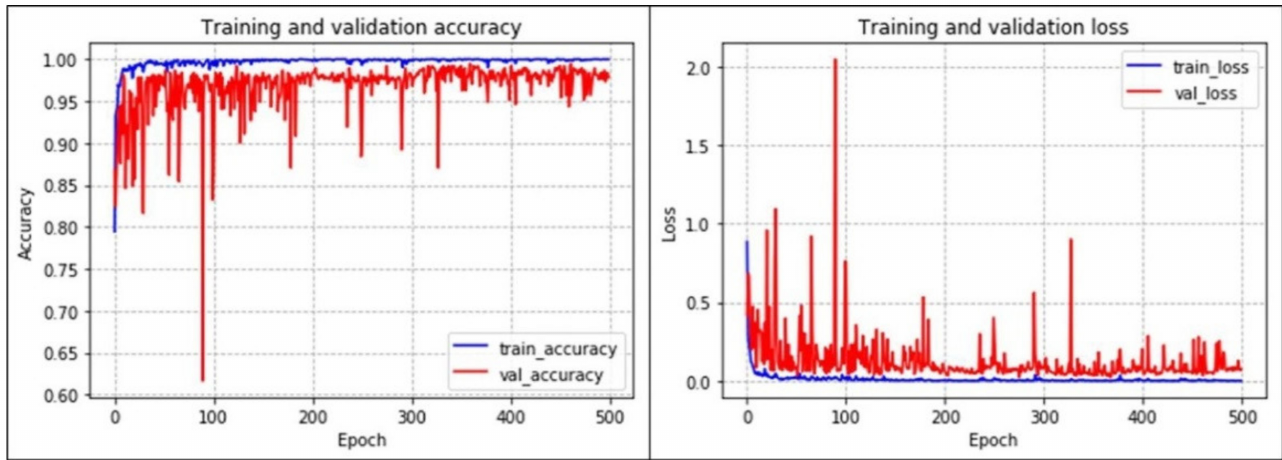
Figure 15. The accuracy and loss error of improved VGG19 network.